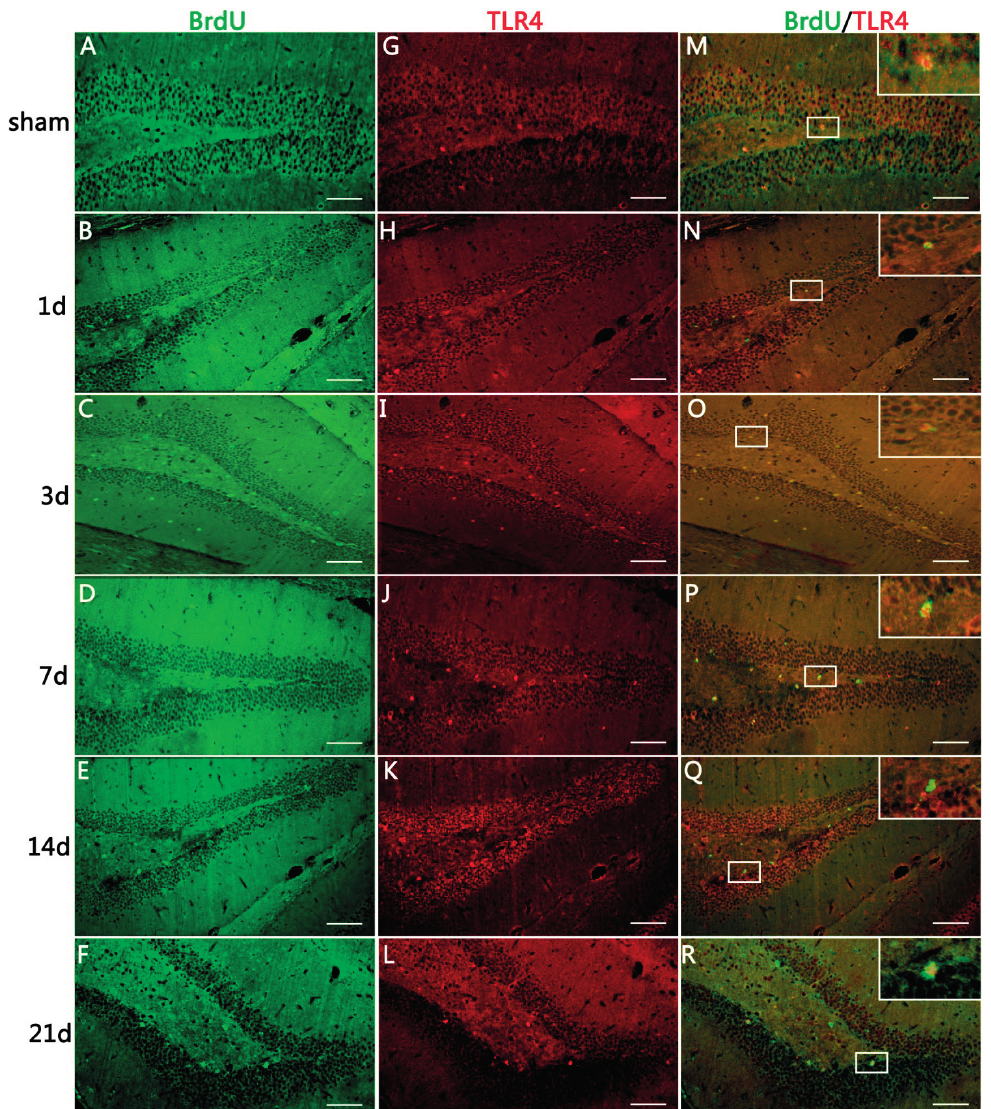
Figure 2. Immunofluorescence (IF) microphotographs in dentate gyrus (DG) of the hippocampus in sham- and TBI-mice with various survivals post-injury. ( A – F ) 5-bromo-2-deoxyuridine (BrdU) (green) indicating neural stem cells (NSCs) in DG; ( G – L ) Toll-like Receptor 4 (TLR4) (red) indicating TLR4 expression in DG; ( M – R ) Merged IF of BrdU/TLR4 indicating TLR4 expression on the proliferating cells (suggestive of NSC proliferation), the rectangle area, taken from a magnified optic field, showing BrdU/TLR4 expressed in/on a newly-generated cell; ( S )The number of BrdU + cells revealing the degree to which putative NSCs have proliferated in DG varies over different survivals post-injury. TBI-mice has significantly more BrdU + cells than the sham ( * p < 0.05), and shows an obvious difference in the number of these cells between all post-traumatic time-points ( # p < 0.05); ( T ) The number of BrdU + /TLR4 + cells revealing the degree of TLR4 expression in the proliferating cells in DG varies over different survivals post-injury. TBI-mice has significantly more BrdU + /TLR4 + cells than the sham ( * p < 0.05), and shows an obvious difference in the number of these cells between all posttraumatic time-points ( # p < 0.05). Scale bar: 50 μ m. Data are presented as Mean ± SD, n = 6. SD: standard deviation, d: